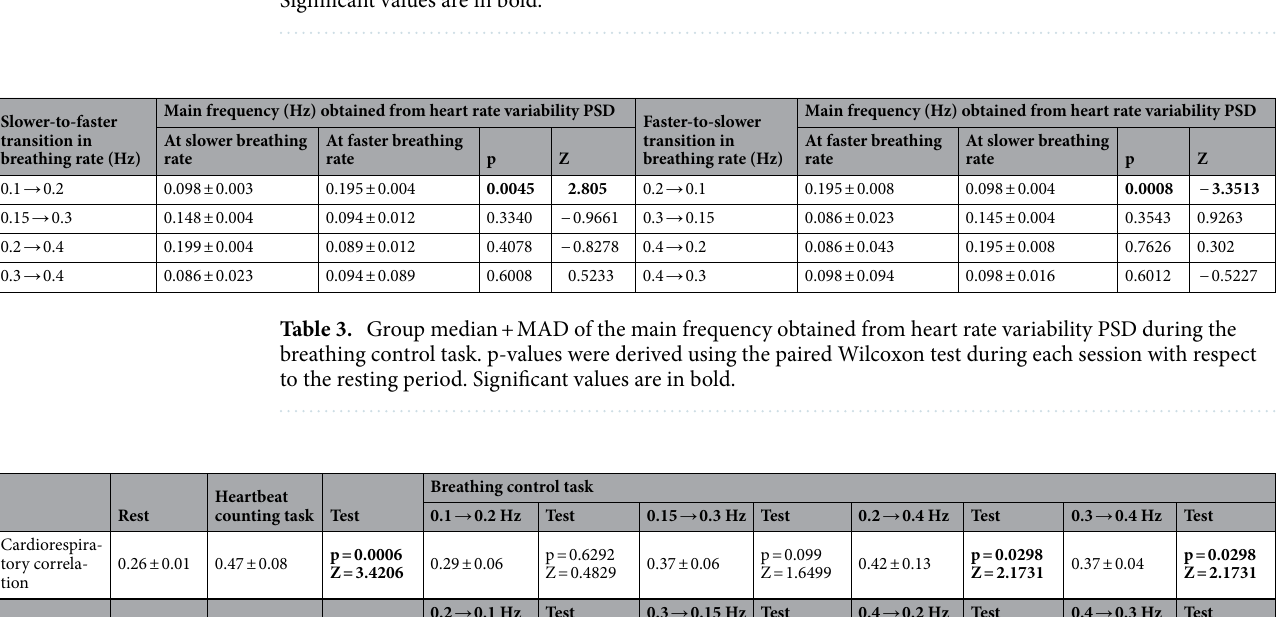
Table 2. Group median + MAD of the average normalized heart and breathing rates and the main frequency in the PSD of the heart and breathing rates during the heartbeats counting task. p-values were computed using the paired Wilcoxon test over a 30-s period of counting heartbeats and a subsequent 30-s resting period. Significant values are in bold.